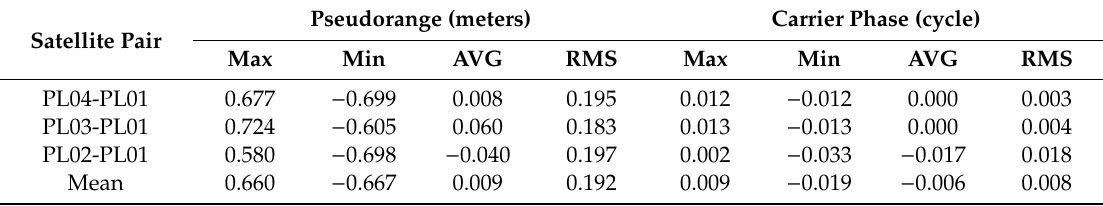
Table 2. Characteristics of pseudolite measurement error for zero baseline.